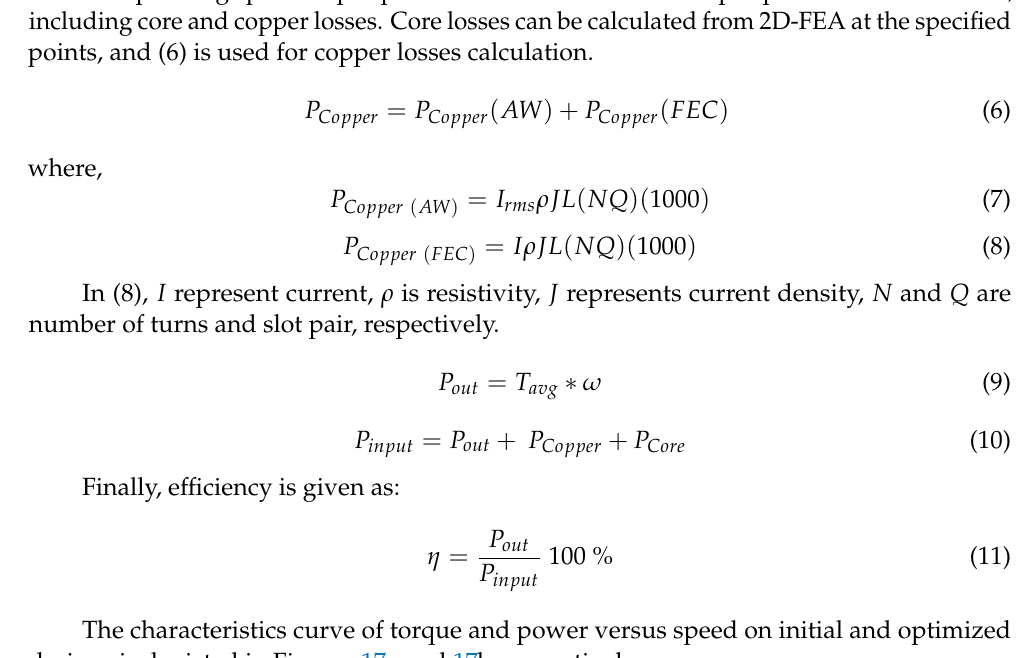
Table 4. Performance comparison of initial and optimized design.